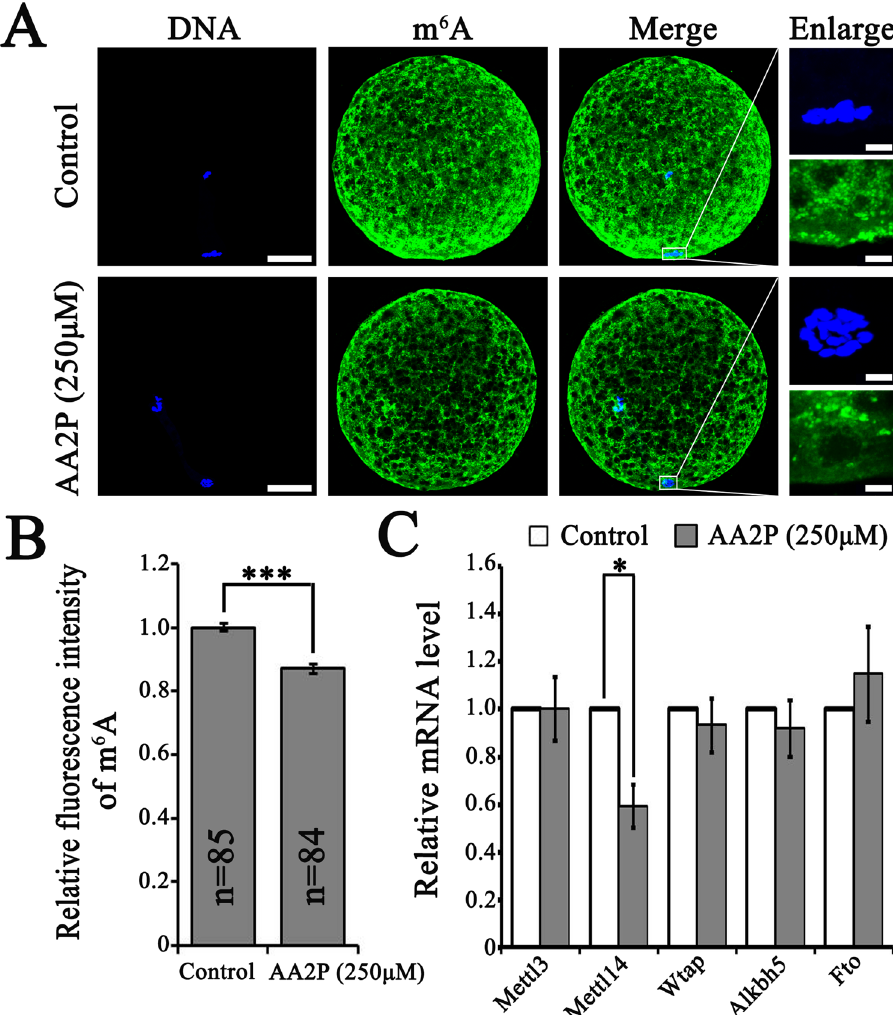
Figure 5. AA2P decreases global m 6 A level in pig oocytes. ( A ) Immunofluorescence staining of m 6 A modification. Scale bar: 50 µ m for first three columns and 5 µ m for final column. ( B ) Quantitative analysis of m 6 A level in mature oocytes from control and 250 µ M AA2P treated groups. ( C ) Relative mRNA levels of m 6 A related genes ( Mettl3 , Mettl14 , Wtap , Alkbh5 , Fto ). * Indicates significant difference at P < 0.05 level and *** P < 0.001